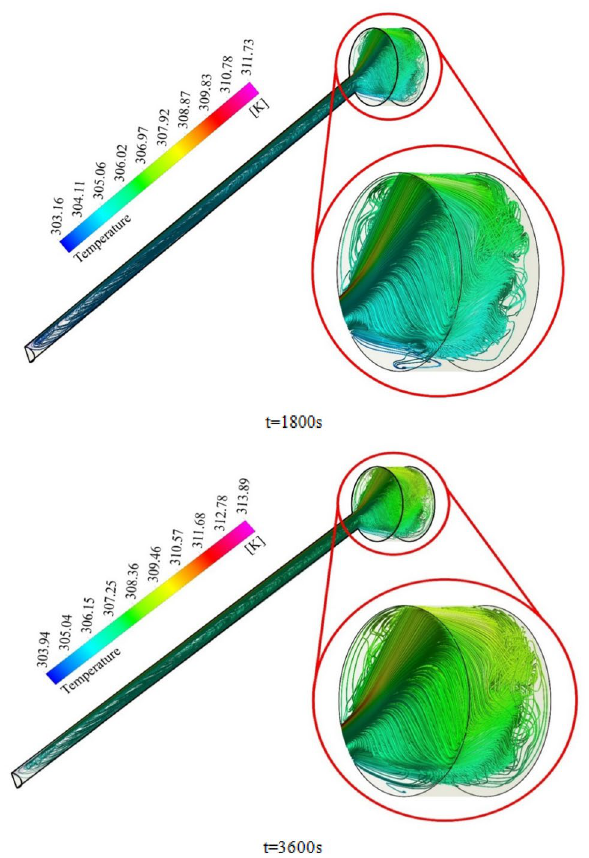
Figure 8. Illustration of temperature for H 2